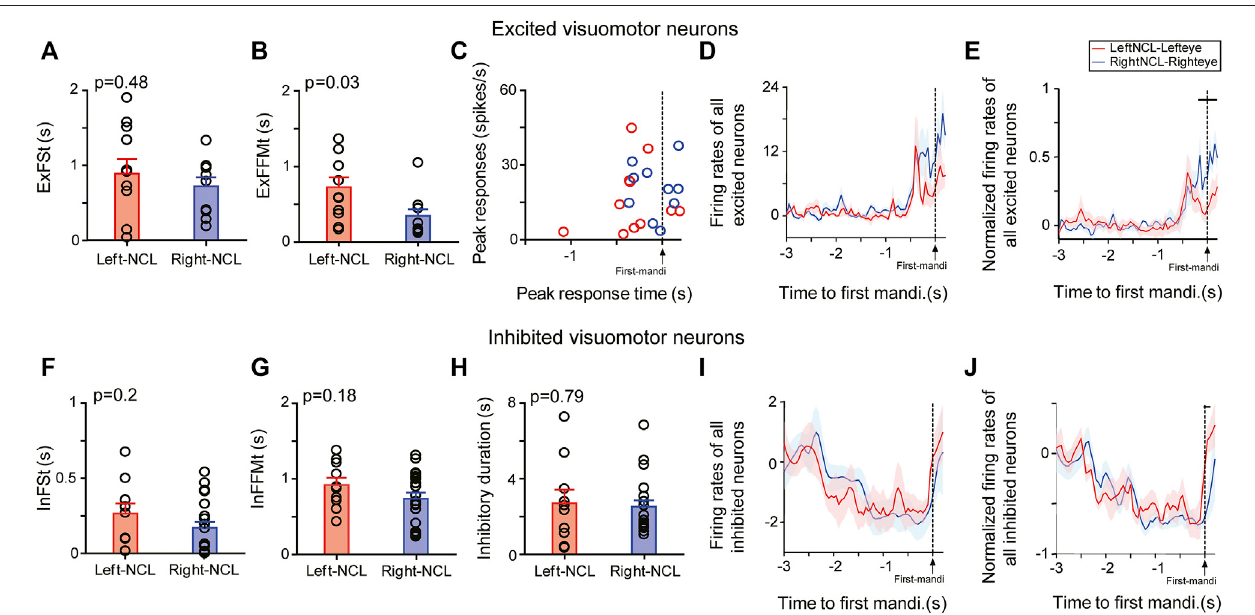
FIGURE7| ResponsesofvisuomotorneuronstoGo-stimulipresentedtotheipsilateraleye.Responsecharacteristicsofexcited (A – E) andinhibitedneurons (F – J) in the NCL to stimuli presented to the ipsilateral eye (ExFSt; InFSt) and their subsequent ability to swiftly activate a motor response (ExFFMt; InFFMt). Mean response onset time (± SEM) of excited (A) and inhibited neurons (F) to Go-stimuli. Mean latency (± SEM) between neuronal and behavioral onset in excited (B) and inhibited neurons (G) . (C) Peak activities and peak- fi ring times of excited neurons in left and right NCL. Mean fi ring rates (± SEM) of excited (D) and inhibited visuomotor neurons (I) relativetothe fi rstresponseoftheanimaltoipsilateralstimuli.Normalizedmeanresponses(±SEM)ofexcited (E) andinhibitedvisuomotorneurons (J) relative tothe fi rstresponseofthe animal.Firing rates ofeach neuronwere normalized toits peak (excitedneuron) or lowestresponse(inhibited neuron).The horizontal lines inE and J indicate the signi fi cance level of the comparison of left and right NCL neurons (p < 0.05). (H) Duration of inhibitory responses of inhibited neurons.